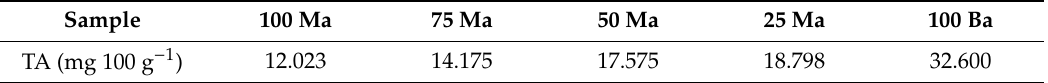
Table 1. Total anthocyanin content (TA) of maqui-blackberry